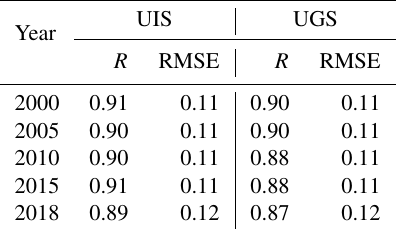
Table 3. Accuracy assessments for the UIS and UGS